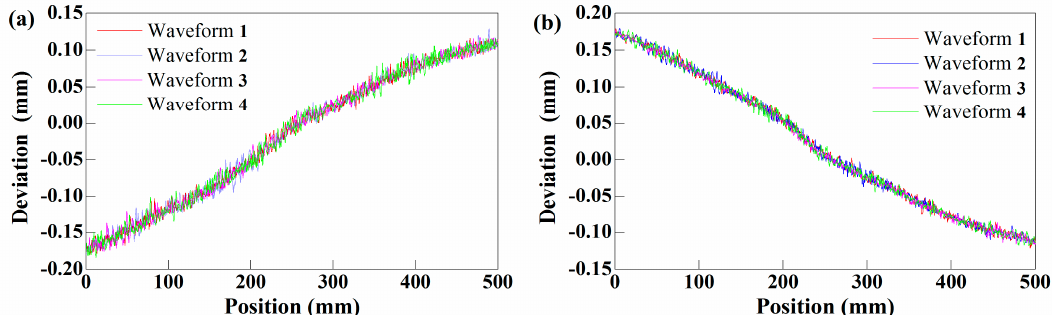
Figure 21. Combined projection waveforms of spatial sequence ( a ) PB is the measured surface. ( b ) PA is the measured surface.